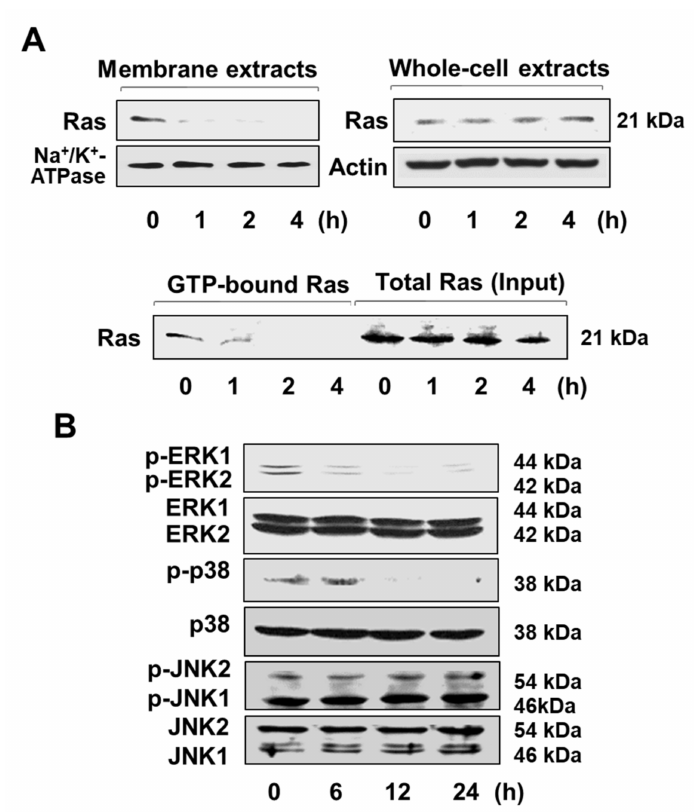
Figure 6. Lycopene inhibits the activation of Ras and mitogen-activated protein kinases (MAPKs). The cells were treated with 2 µ M lycopene for the indicated time periods. ( A ) The levels of Ras in membrane extracts and whole-cell extracts were assessed by Western blot analysis using anti-Ras antibody (upper panel). Na + / K + -ATPase was used as a marker of membrane fraction. Actin served as a loading control. The activation of Ras was determined by a ffi nity purification using glutathione S-transferase (GST) fusion protein containing the Ras binding domain (GST-RBD) followed by Western blot analysis. The Ras level in whole-cell extracts was considered as total Ras (input) (lower panel). ( B ) The phospho- and total forms of extracellular signal-regulated kinase (ERK) 1 / 2 (p44 / p42), p38, and jun kinases (JNK) 2 / 1 (p54 / p46) were assessed by Western blot